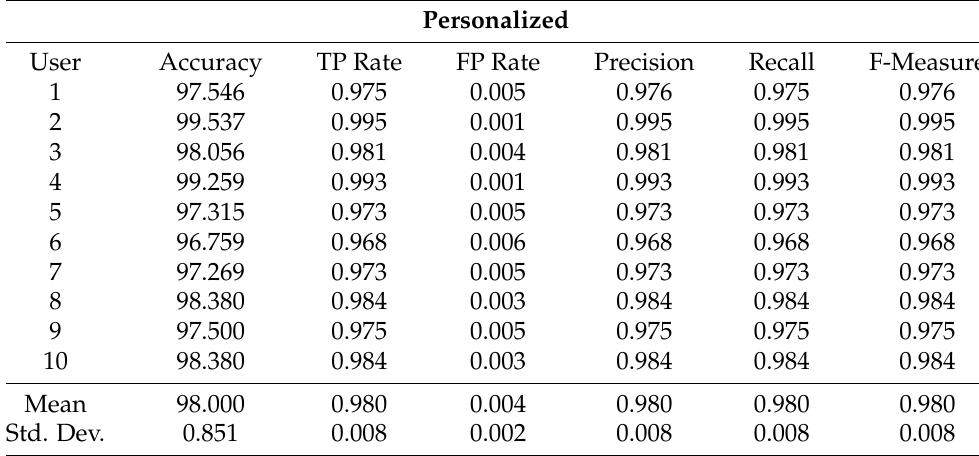
Table 5. Random Forest results for personalized model in SHOAIB